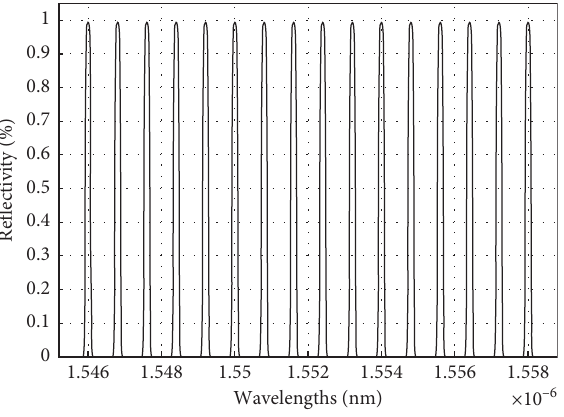
Figure 13: Reflectivity of 16 optical channels. Table 2: Reflectivity, FWHM, and SLL of 16